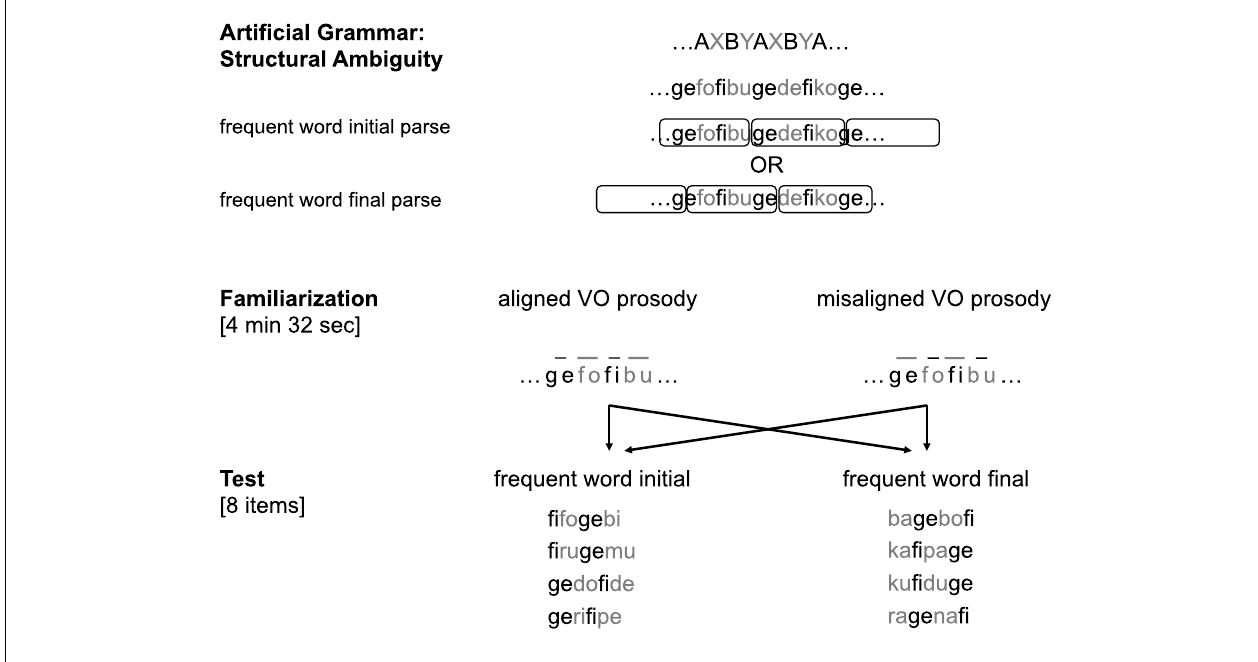
FIGURE 1 |The material used in Conditions 1 and